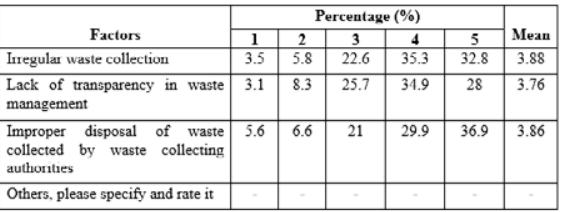
Table 3: Factors that hinder the respondents from participating in